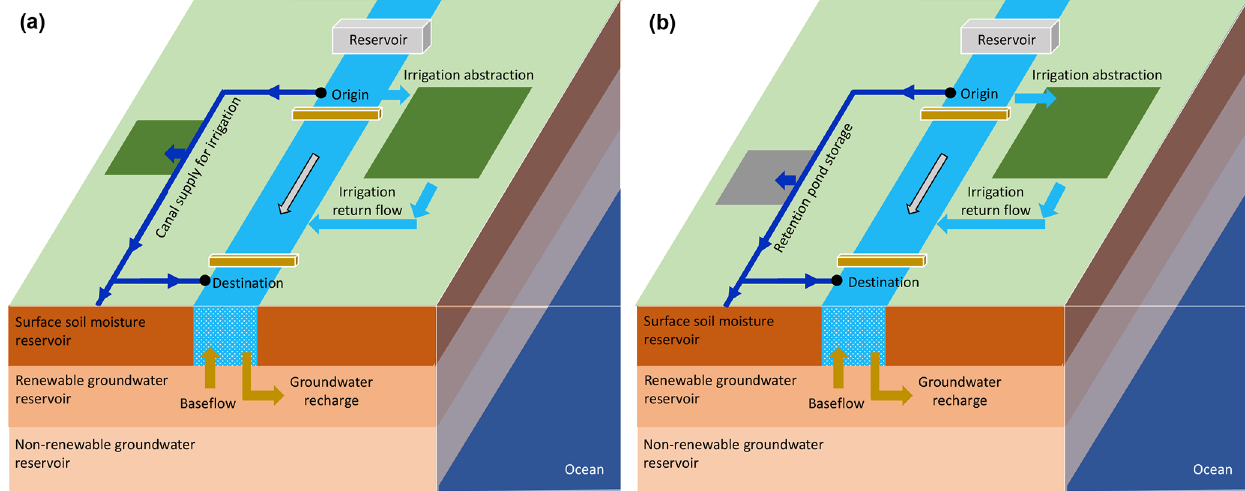
Figure 1. Schematic diagram of the canal diversion scheme of the enhanced H08 model during the (a) dry season and (b) wet season. Blue, green, orange, and grey symbols denote water, land, underground reservoirs, and retention areas,